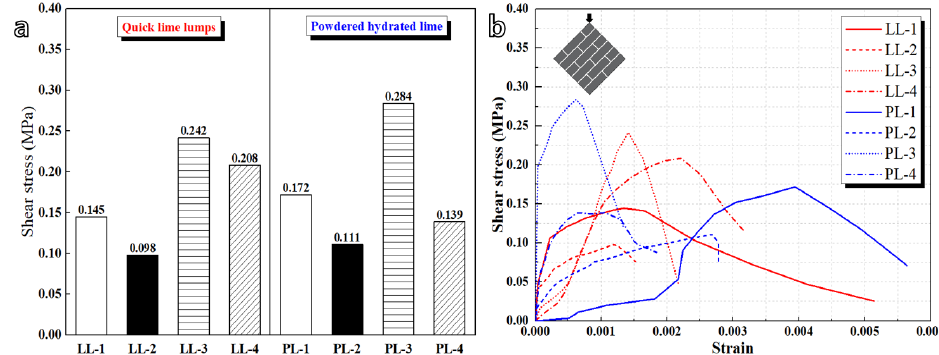
Figure 19. Diagonal compression test results. ( a ) Shear strength, ( b ) strain–stress curve.